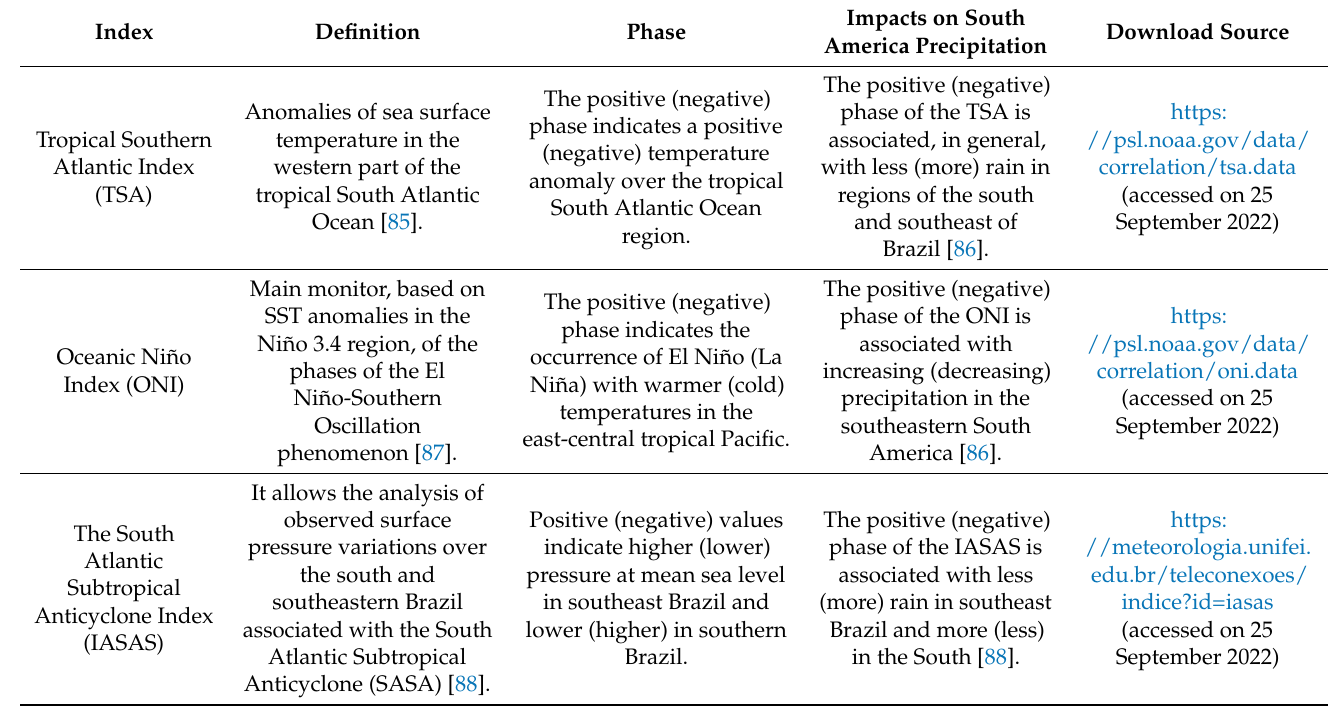
Table 2. Summary of the teleconnection indices used in the